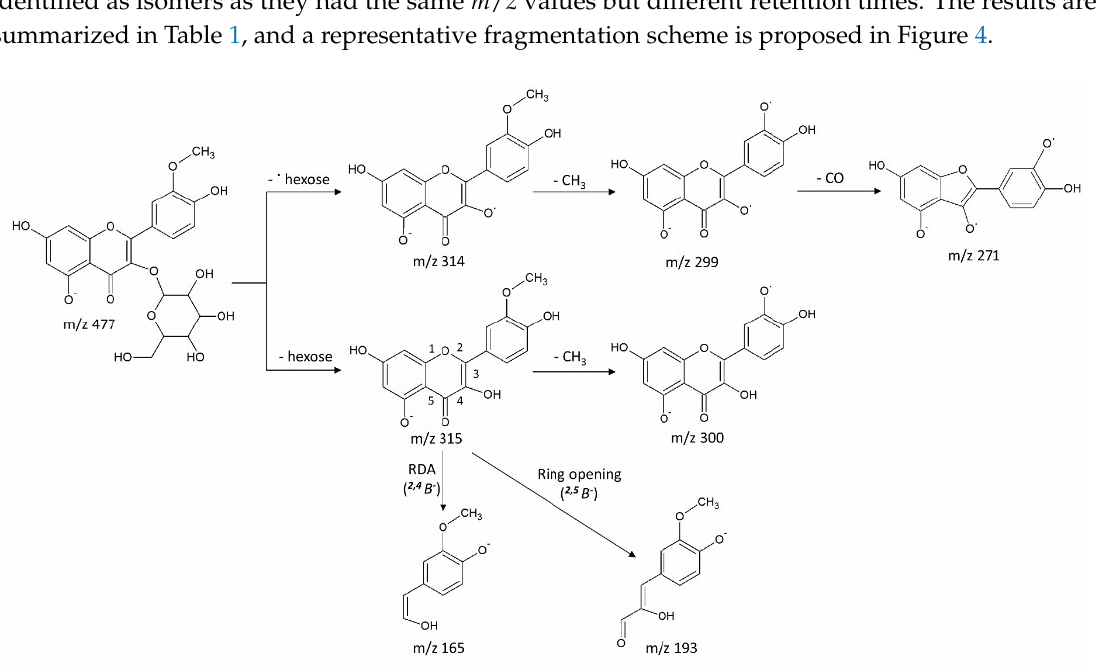
Figure 4. Proposed fragmentation of Peak 3 (9.38_477.1039). The fragmentation included loss of carbohydrate moiety, methyl group, and ring opening and re-arrangement. Fragments and their intensities are listed in Table 1.